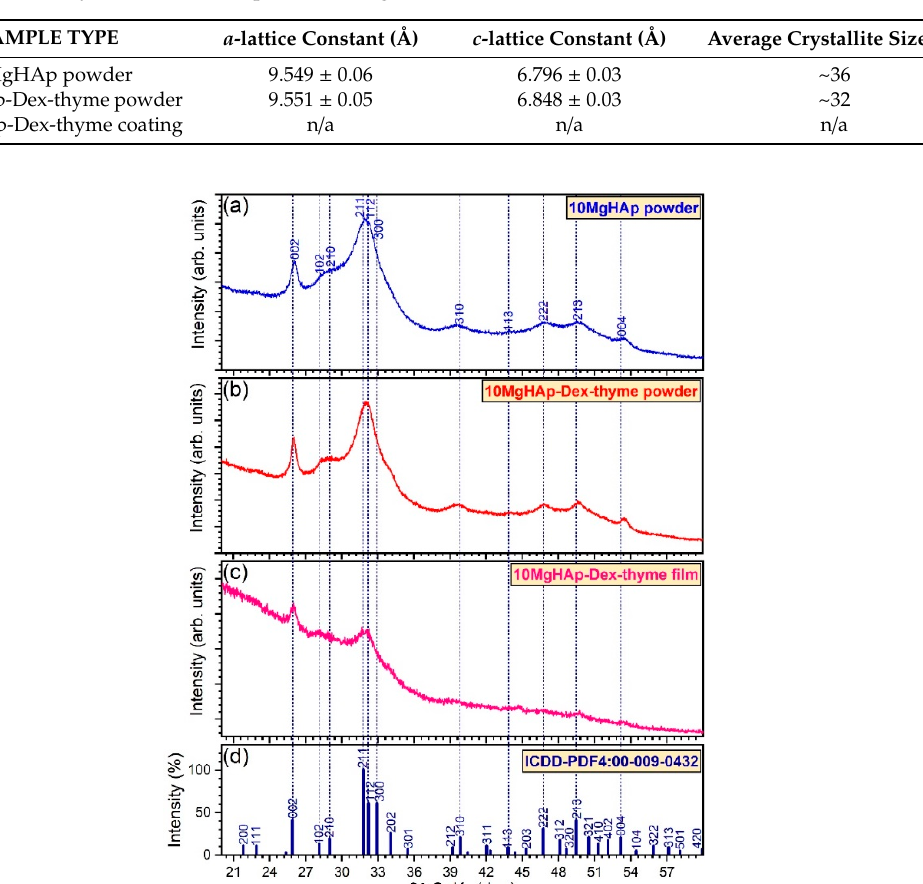
Table 1. Lattice parameters and average crystallite size for the magnesium-doped hydroxyapatite (10MgHAp) and dextran-thyme magnesium-doped hydroxyapatite (10MgHAp-Dex-thyme) powders (as extracted by Rietveld whole pattern fitting).